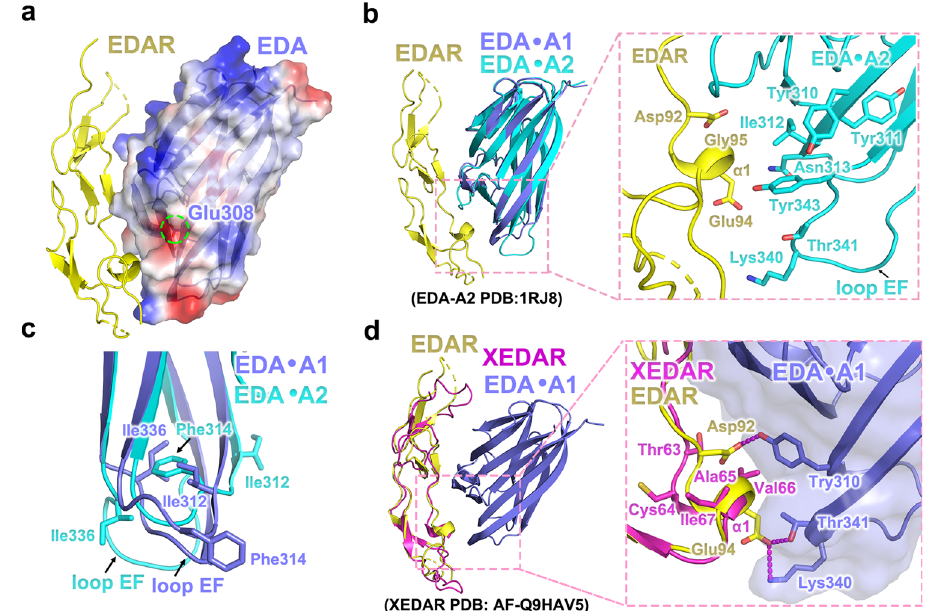
Fig. 3| Theinteractionspeci fi city betweenEDA·A1 THD and EDAR CRDS .a Residue Glu308 in EDA·A1 THD exhibits no direct interaction with EDAR CRDS . EDA·A1 THD is shown in electrostatic potential surface representation with residue Glu308 denoted by a dashed green circle. The EDAR CRDS is shown in cartoon mode. b StructuralcomparisonofEDA·A1 THD and EDA · A2 THD . The structureofEDA · A2 THD (PDB: 1RJ8) is superimposed onto the EDA·A1 THD -EDAR CRDS structure. A close-up view of the interface centered at helix α 1 of EDAR CRD2 is shown on the